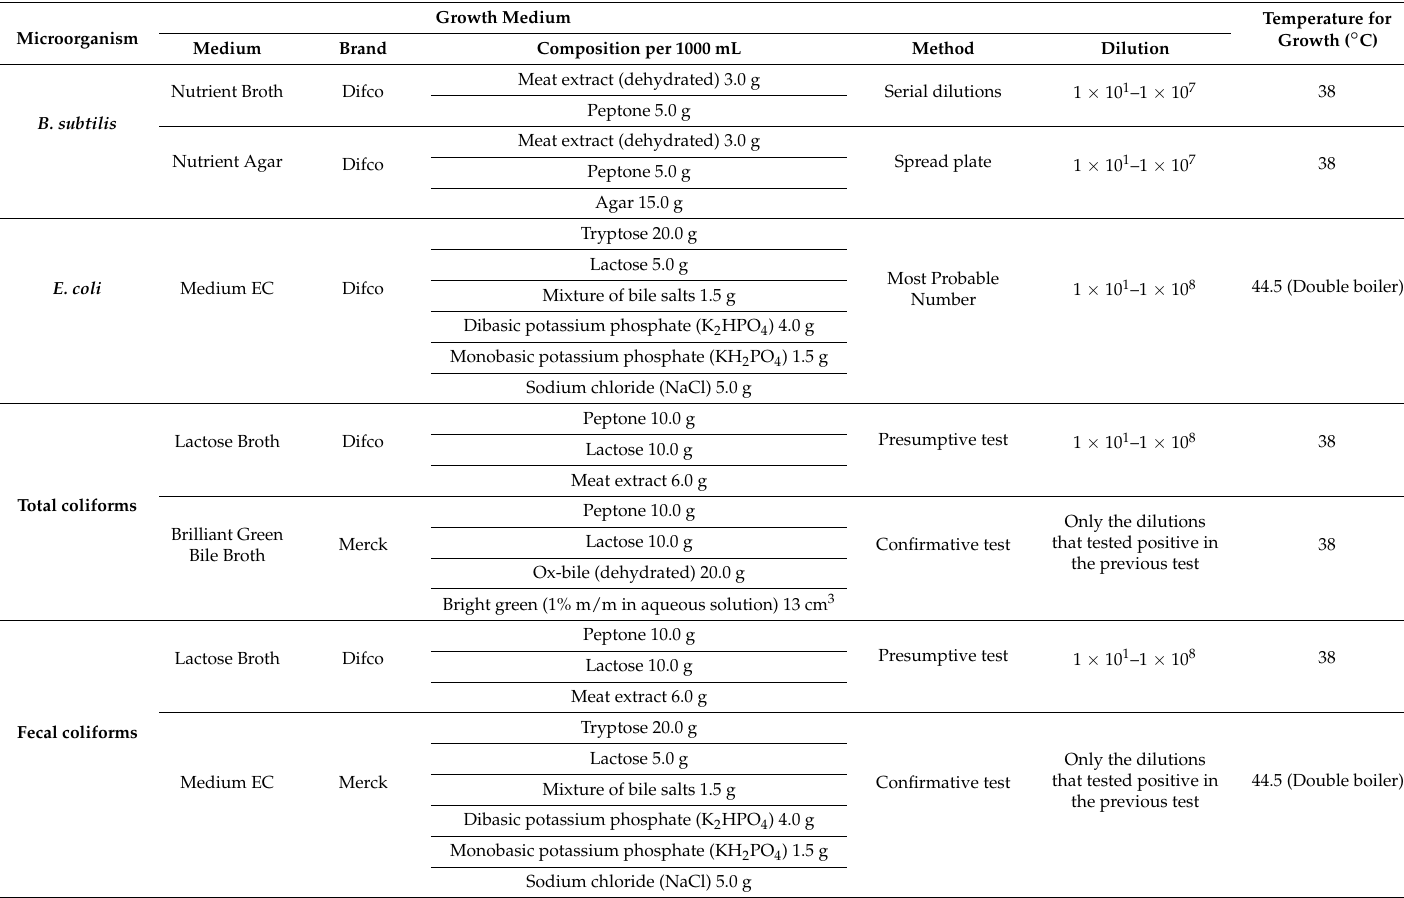
Table 1. Main characteristics of the methodologies used for quantifying the microorganisms evaluated during sonication